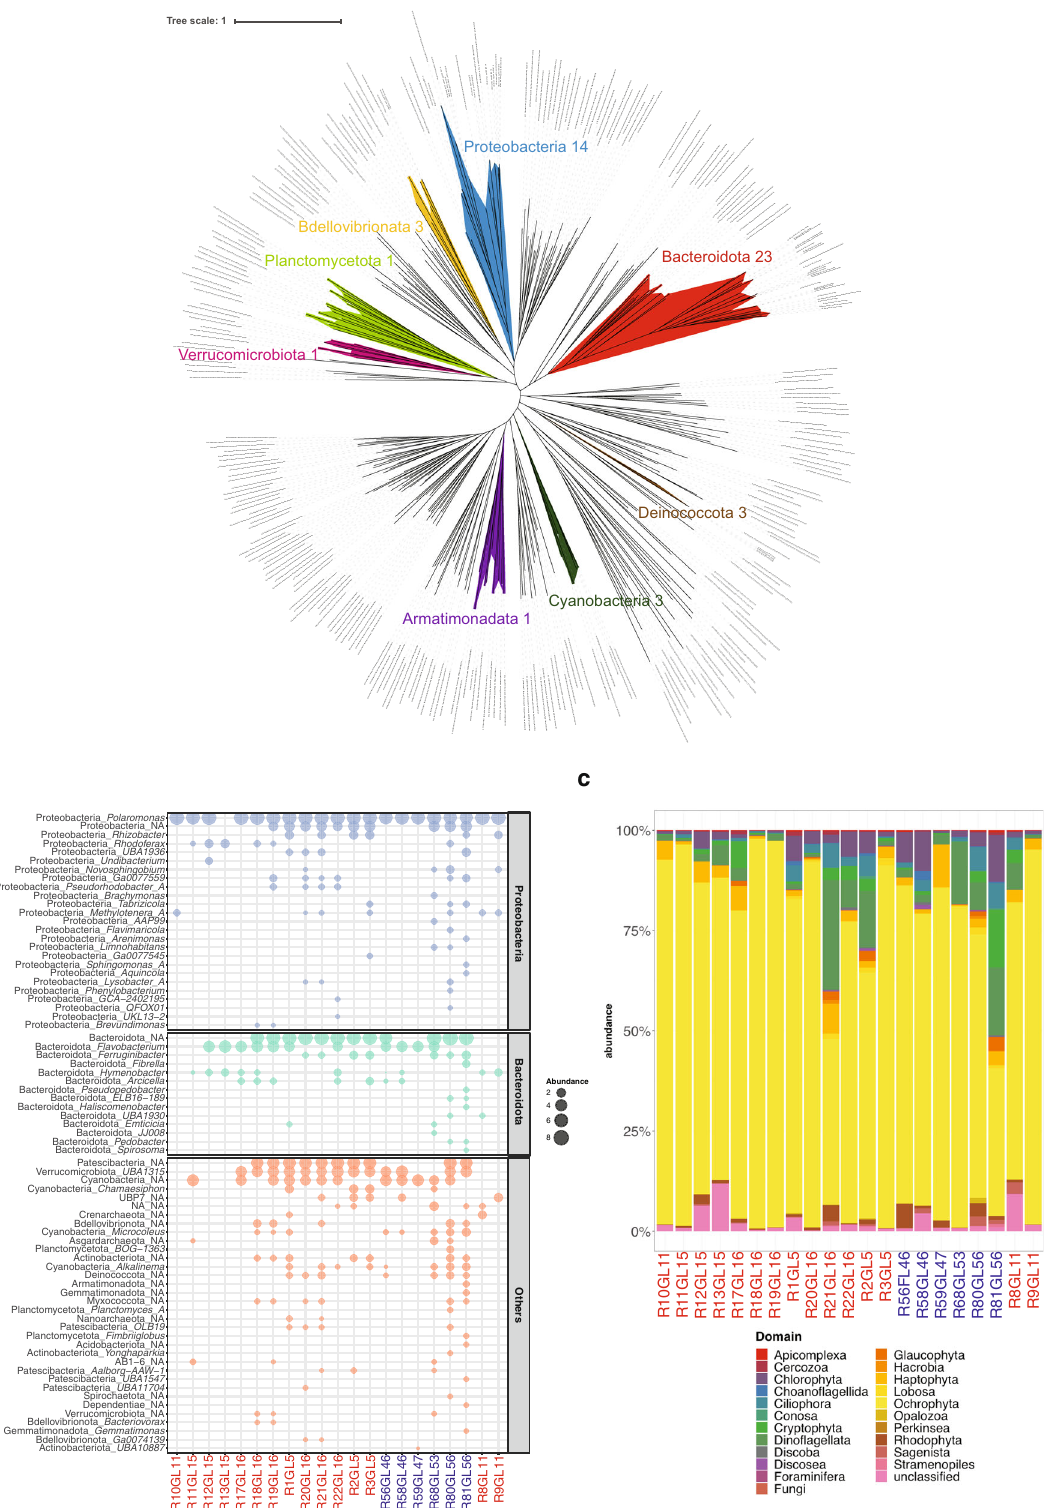
Fig. 2 Metagenomics unveils the complexity of epilithic bio fi lms. a Bacterial phylogenetic tree constructed using high-quality ( n = 49, >90% completion and <2% contamination) MAGs reconstructed from the epilithic bio fi lms. The numbers beside the phylum names indicate the number of high-quality MAGs assigned to the respective phylum. Only high-quality MAGs were used to mitigate phylogenetic disparities from incomplete MAGs. b Normalized abundance of reconstructed prokaryotic genomes, i.e., MAGs, from the epilithic bio fi lms. Taxonomy at phylum and genus levels is depicted. NA: unclassi fi ed genus. Samples from the Southern Alps are indicated in red, while those from Caucasus are shown in blue. Medium-to-high quality MAGs ( n = 73) are depicted. c Eukaryotic relative abundance pro fi le obtained from metagenomic sequencing across all epilithic bio fi lms